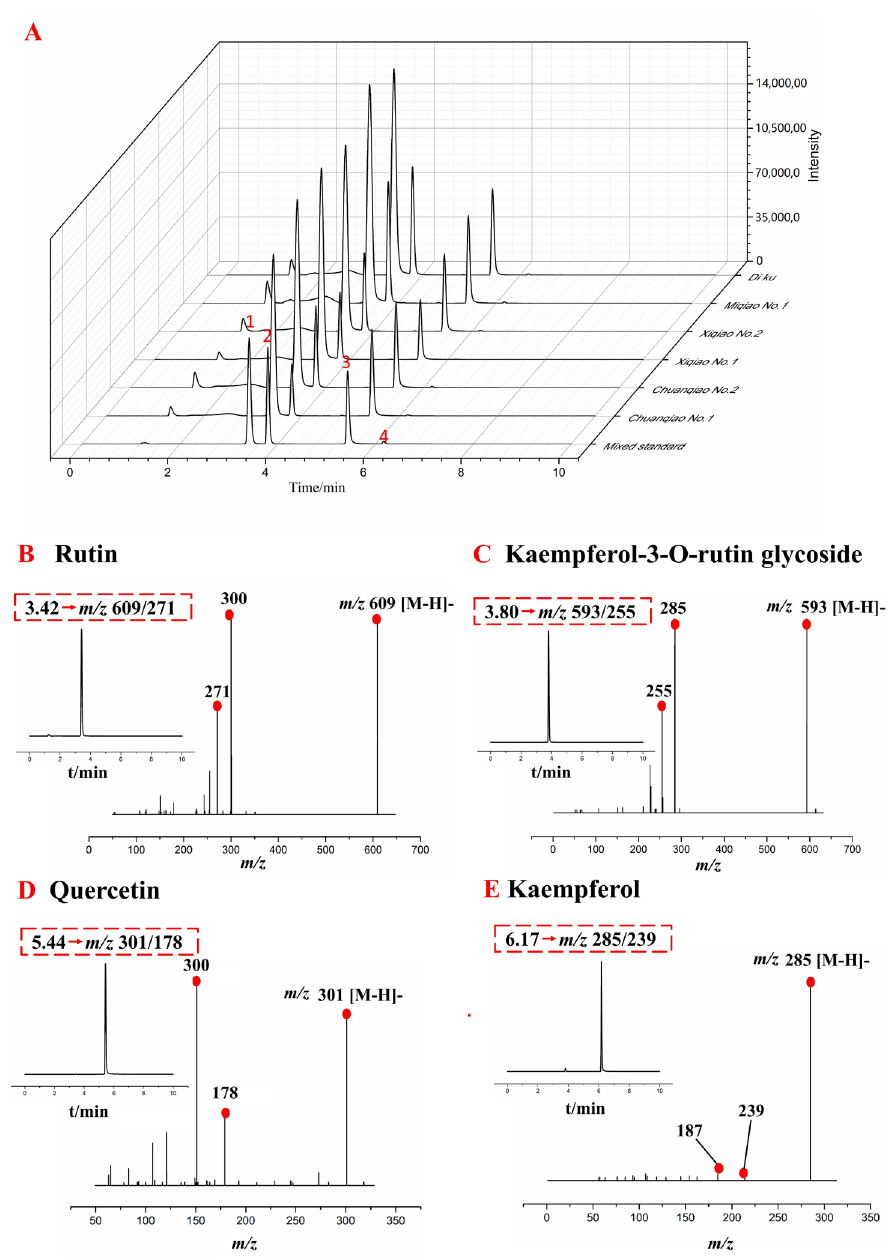
Figure 3. ( A ) Total ion flow diagram of different varieties of Tartary buckwheat, ( B – E ) primary and secondary mass spectrometry information of four flavonoids. Note: 1-Rutin, 2-Kaempferol-3-O-rutin glycoside, 3-Quercetin, 4-Kaempferol.